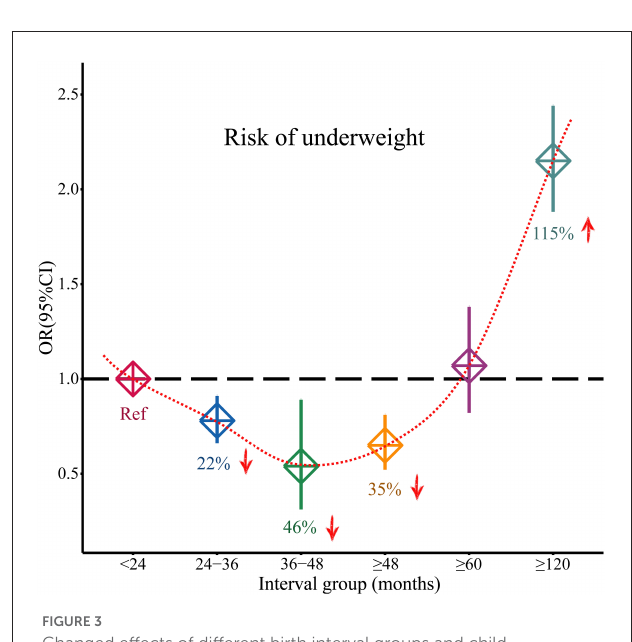
FIGURE3 Changed effects of different birth interval groups and child underweight ( < 24 birth interval group was considered as the reference group; squares represent the ORs, and vertical lines represent the corresponding 95%